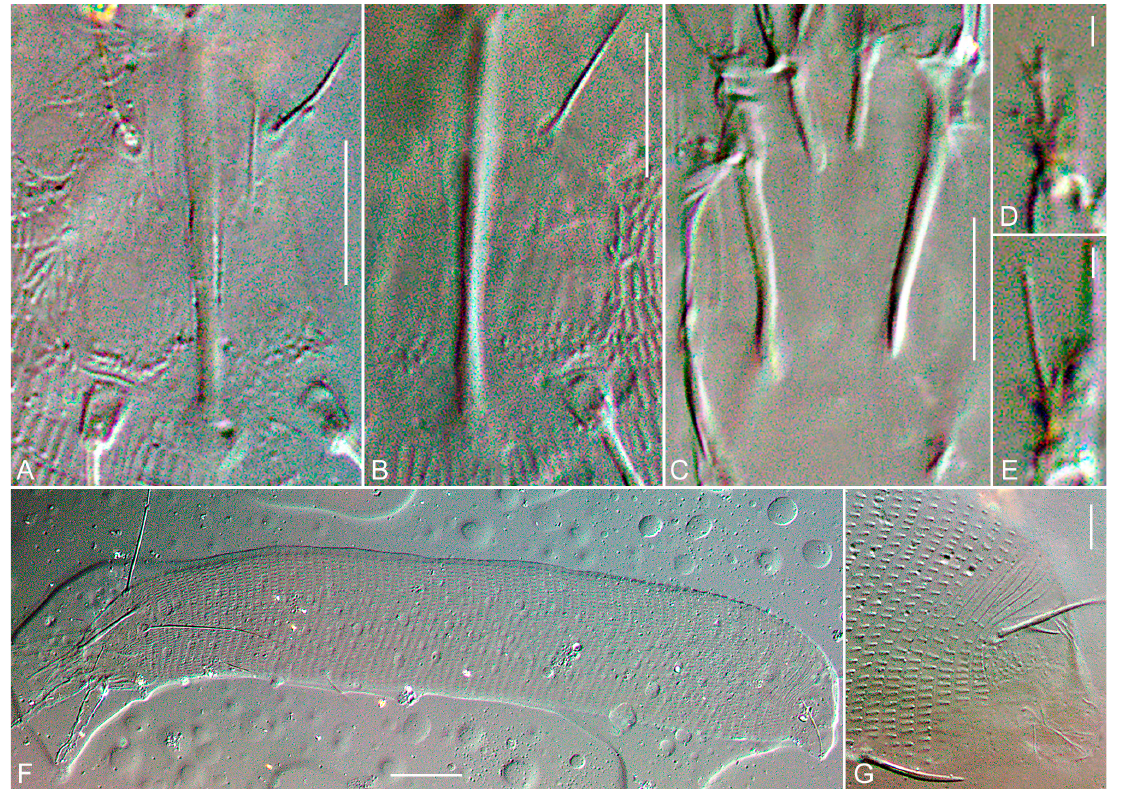
Figure 2. DIC LM images of two paratype females of Novophytoptus ammophilae Skoracka et Boczek 2000. ( A , B )—prodorsal shield, ( C )—coxal apodemes, ( D , E )—empodia I ( D ) and II ( E ), ( F )—entire female, ( G )—dorso-lateral aspect of telosome. Scale bar: ( A – C , G )—10 µm ; ( D , E )—1 µm ; ( F )—30 µm